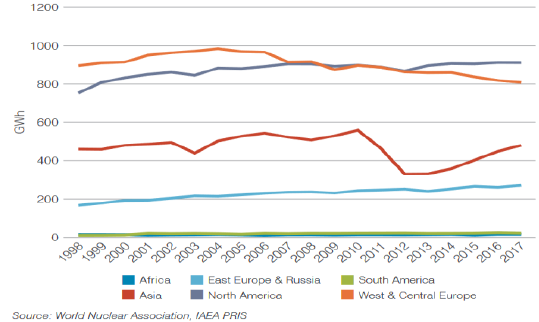
Figure 1. Regional nuclear power generation (World Nuclear Association,